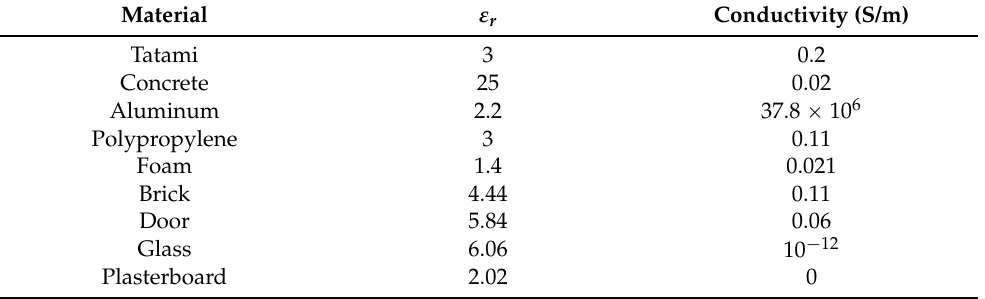
Table 1. Material properties defined for the 3D ray launching simulations. Data obtained from [31].